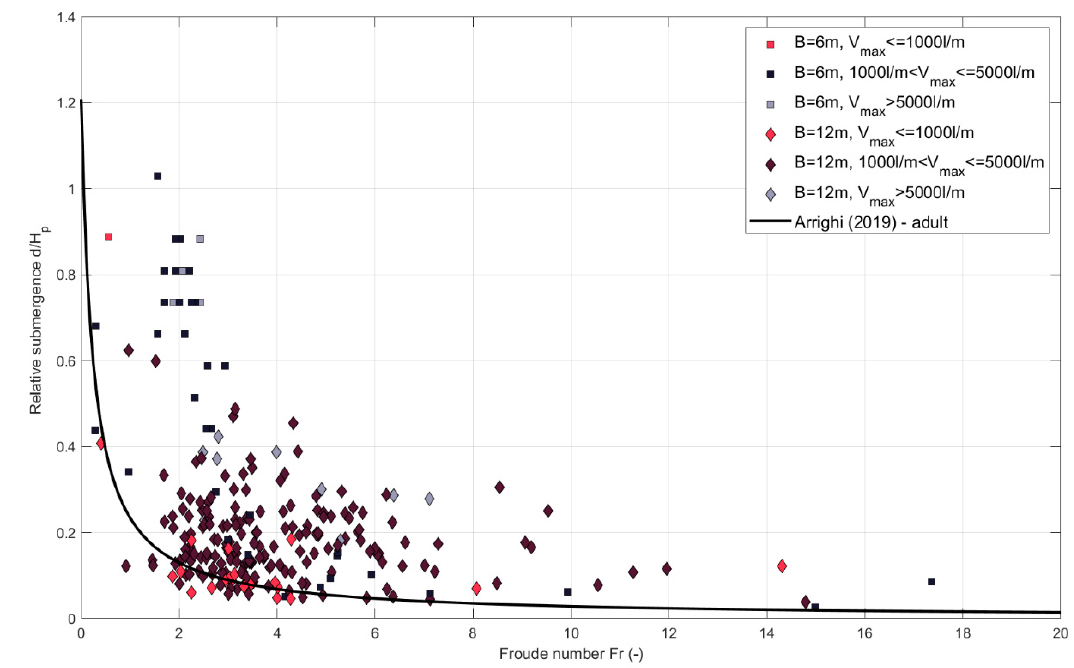
Figure 22. Froude number versus relative submergence, comparison with Arrighi (2017) curve, the discharges are divided for different promenades and maximum volumes.